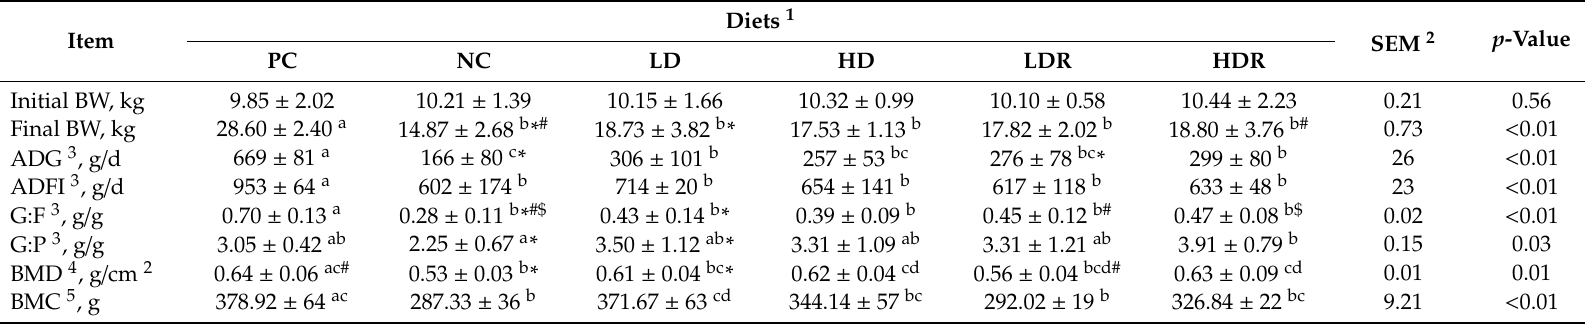
Table 2. Overall growth performance and bone minerals of pigs fed with low-protein diets supplemented with a corn-expressed phytase.